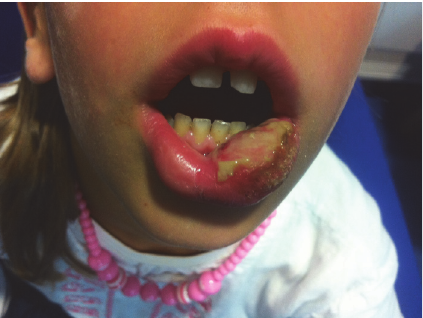
Figure 1: After local anaesthetic self-inflicted trauma to the lower